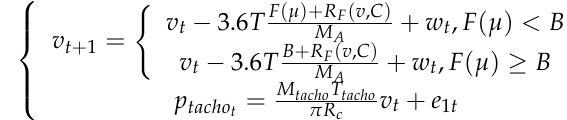
Figure 4. Doppler radar speed sensor and installation example: ( a ) doppler radar speed sensor; ( b ) installation example.